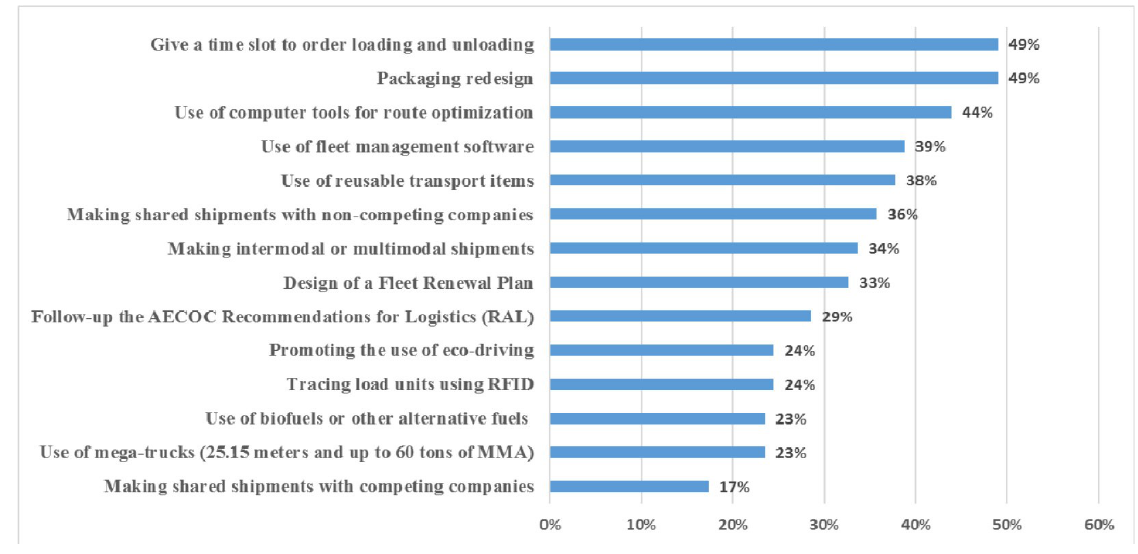
Figure 3. Best practices sorted by use